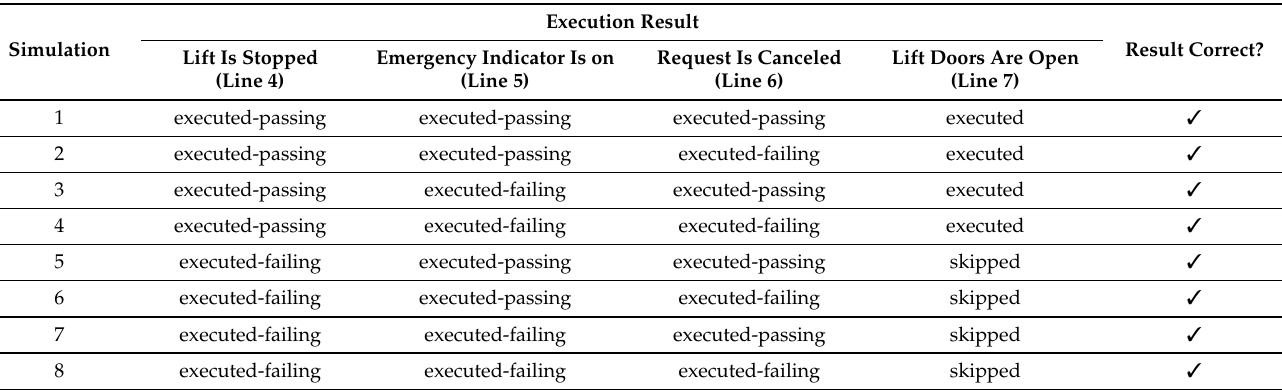
Table 6. Simulation results of executing the lift safety specification in Figure 9: concurrentSpec with the failing-fast option turned off at the right